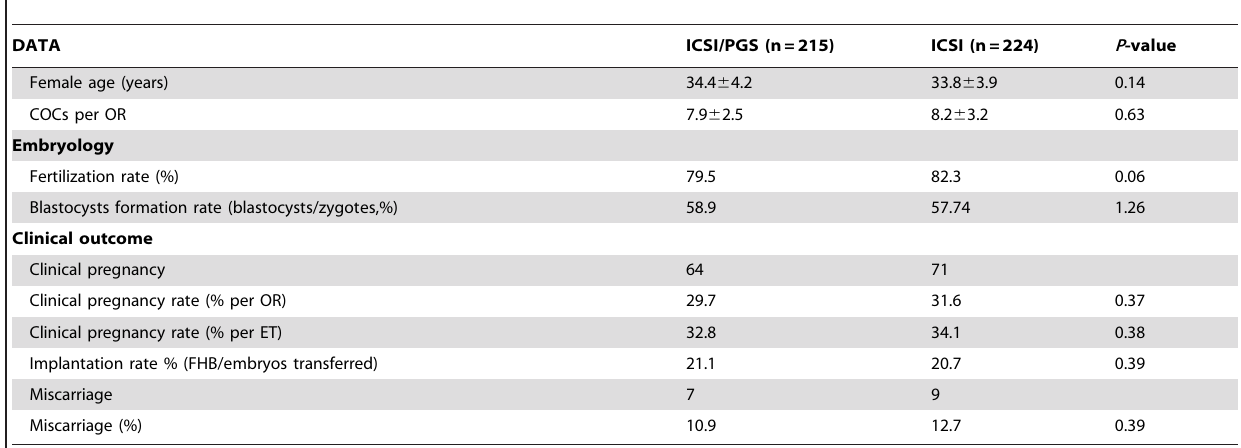
Table 1. Embryological and clinical